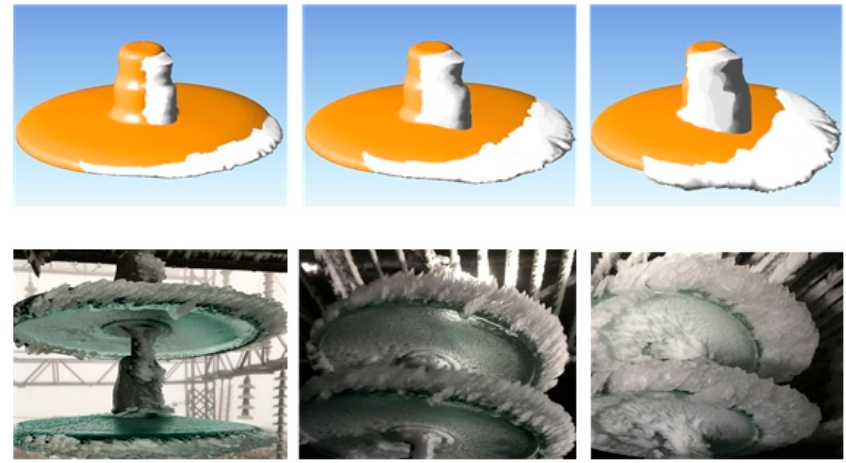
Figure 18. Comparison between test and simulation.